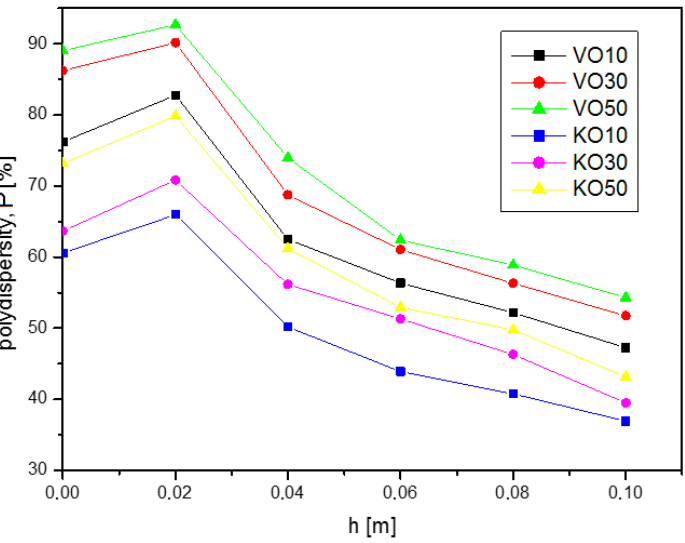
Figure 4. Emulsion polydispersions depending on the height of the fibrous